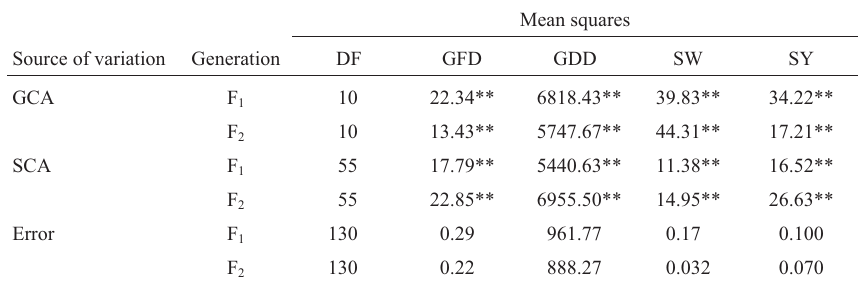
Table 3 - Analysis of variance for combining ability for the grain filling duration (GFD), GFD for growing degree days (GDD), 1000 seed weight (SW) and seed yield (SY) per plant for the F 1 and F 2 offspring of the 11 wheat parents involved in the diallel